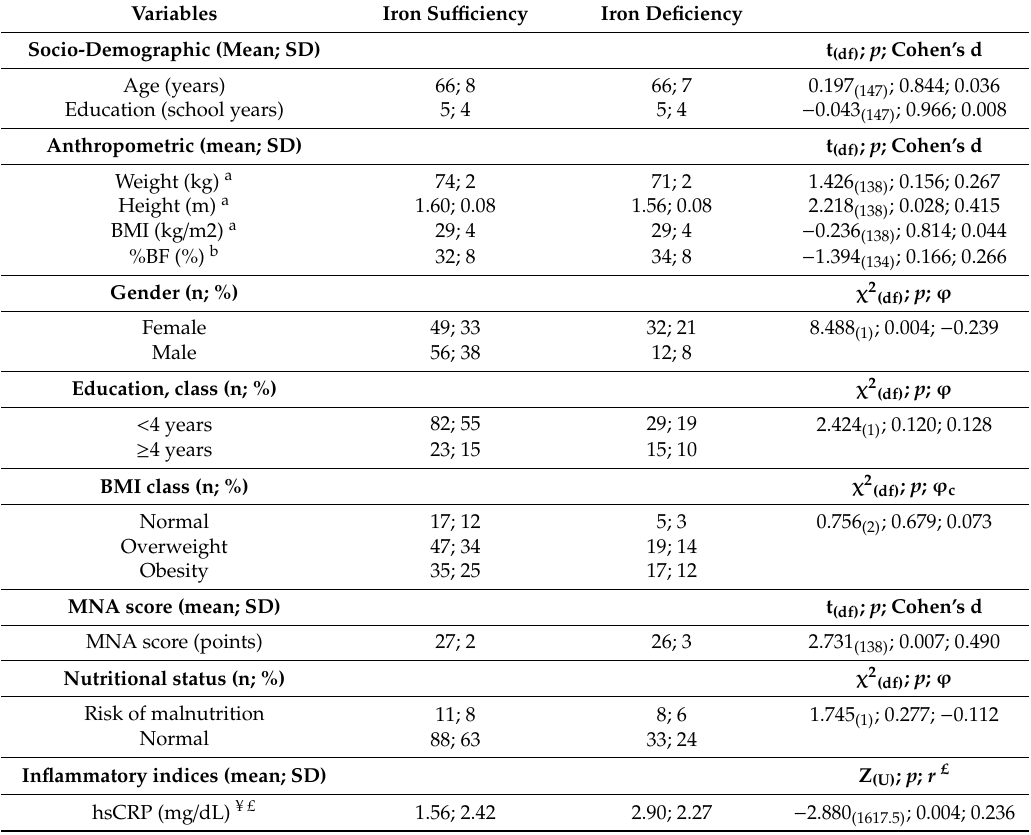
Table 1. Characteristics of participants and di ff erences by group of iron